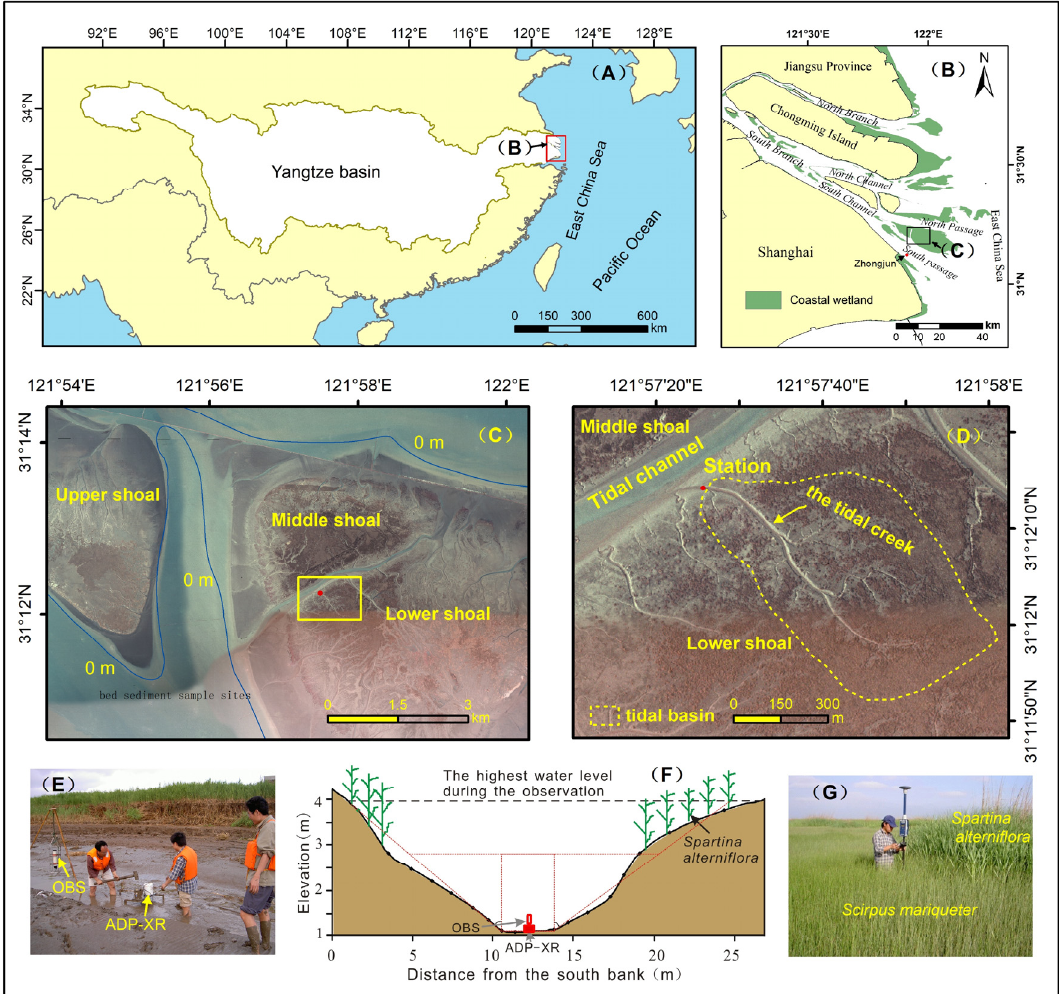
Figure 1. ( A ) Map of the study area showing the location of ( B ) the Jiuduansha Shoal in the Yangtze Estuary. ( C ) High-resolution satellite images showing the tidal creek (Upper, Middle, and Lower shoals), and ( D ) details of the Lower Shoal, showing the locations of data measurements. ( E ) Photograph showing field measurements being collected in the creek in summer. ( F ) Instrument layout in the middle of the tidal creek. ( G ) Photograph showing field observations being conducted on the marsh.